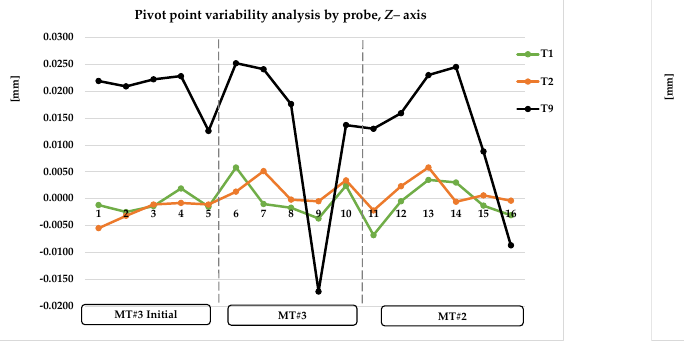
Figure 13. Pivot point measurement variability: ( a ) Z —axis direction, B 0° → B 90° head position; ( b ) X —axis direction, B 0° → B90° head position.